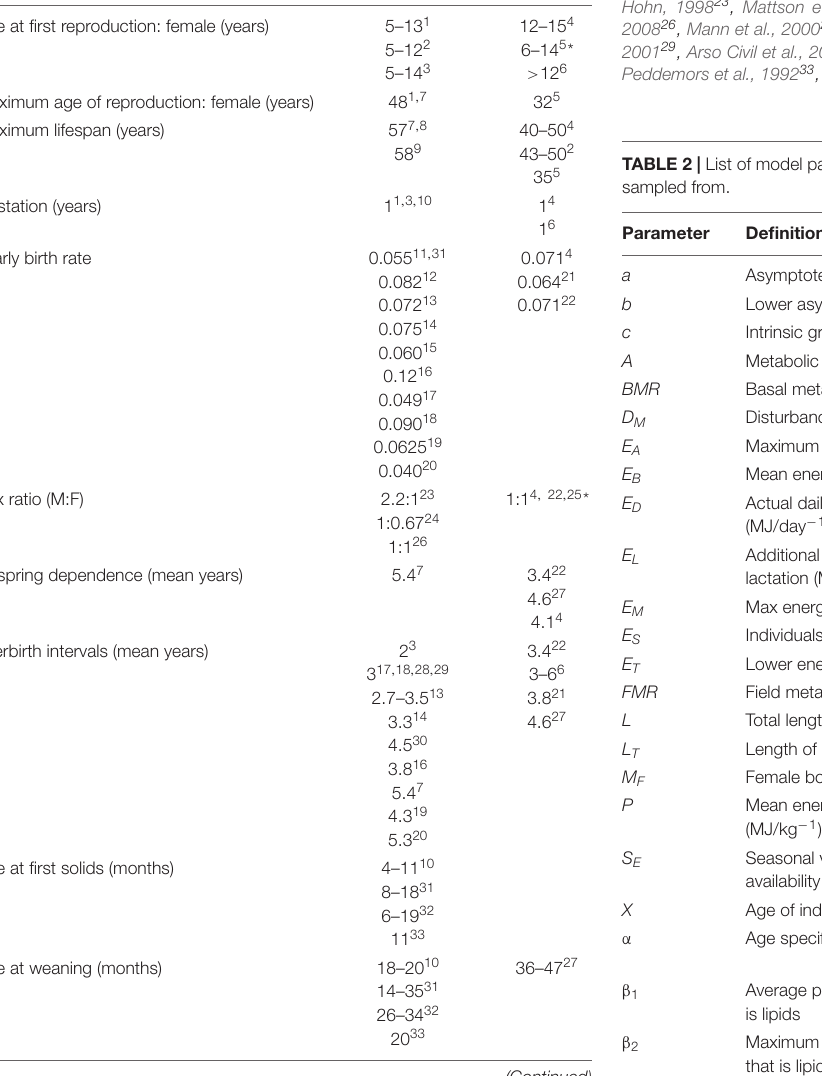
TABLE 1 | Demographic information for bottlenose dolphins used to estimate model parameters that were unknown for the two populations. Parameter